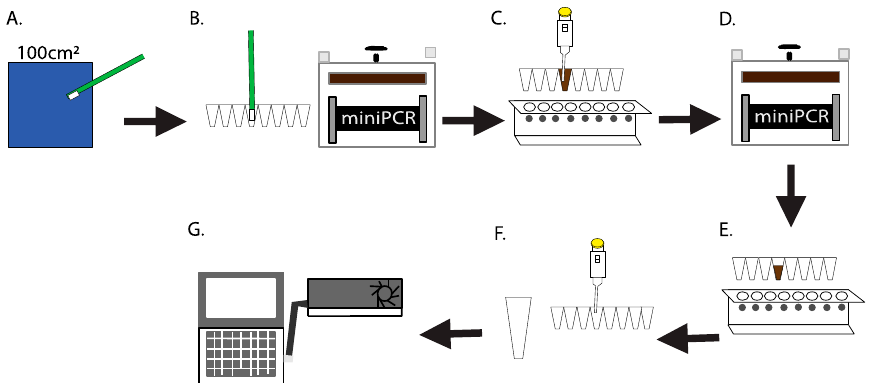
Figure 1. Workflow of the in-situ culture-independent, swab-to-sequencer process for extreme envi- ronment microbial profiling. ( A ) Swabbing of a 100 cm 2 area. ( B ) Insertion of the swab head directly into lysis buffer in a PCR tube and placement into miniPCR for DNA extraction. ( C ) Bead-based DNA purification ( D ) DNA amplification within miniPCR. ( E ) Bead-based PCR amplicon purification. ( F ) Addition of sequencing control DNA and ONT-based rapid adaptor library preparation. ( G ) Flow cell loading and MinION sequencing.